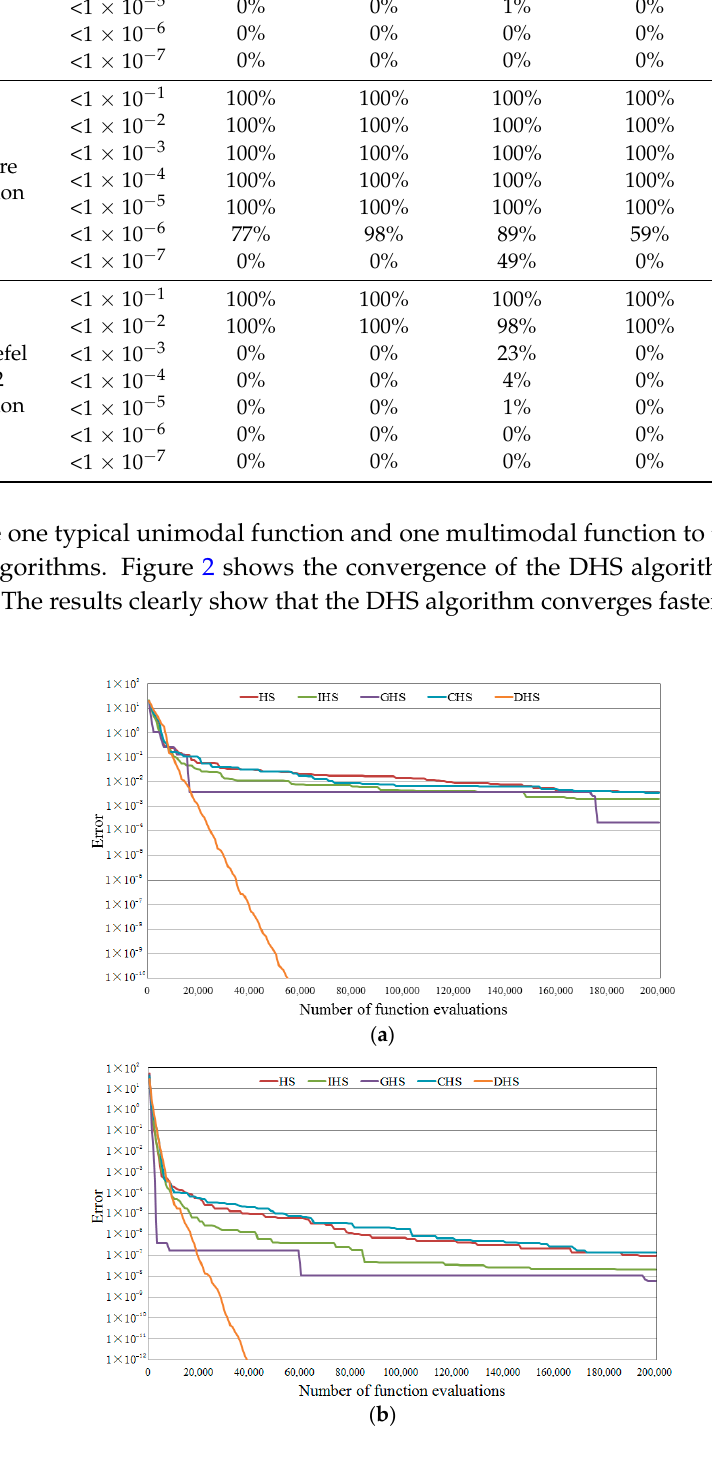
Figure 2. Convergence characteristics: ( a ) Ackley function; ( b ) Sphere function .